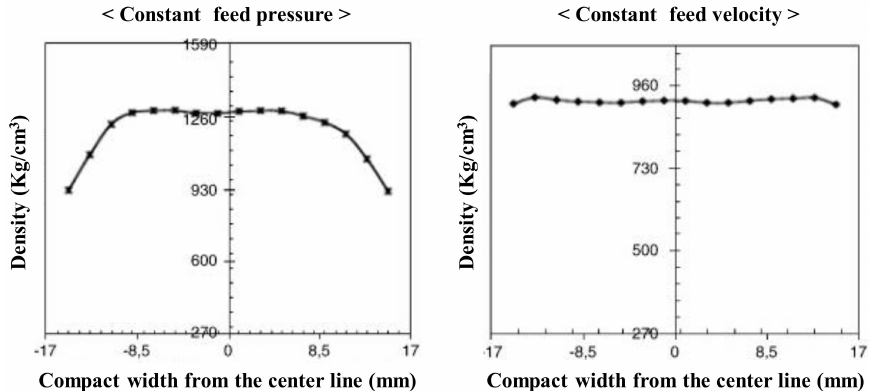
Figure 20. Roller compaction process simulation using FEM [167]: predicted density distribution along the width of the ribbon constant feed pressure ( left ) and feed velocity ( right ). The 0 on the x-axis means center in the width of the ribbon. The figures were slightly modified, with permission from